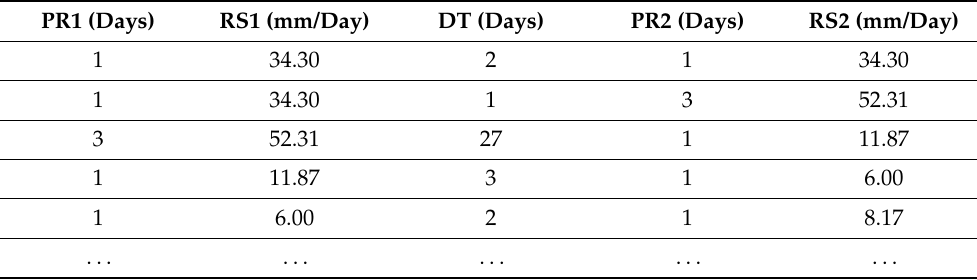
Table 3. Example of rainfall/dry periods for one location from the beginning of the time series until the moment of the event—one